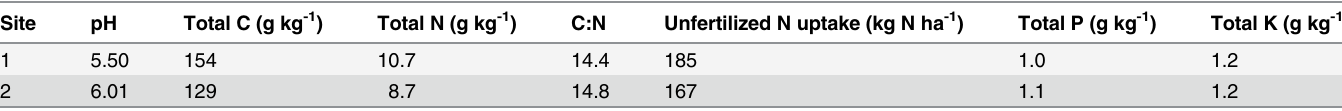
Soil pH, total P, and total K values are based on composite samples from 0 – 15cm depth; total C, total N, and C:N values are based on composite samples from 0 – 30 cm. Unfertilized N uptake is the average of 4 replicates at each site, and is the total amount of N in aboveground biomass (straw + grain) at crop maturity.